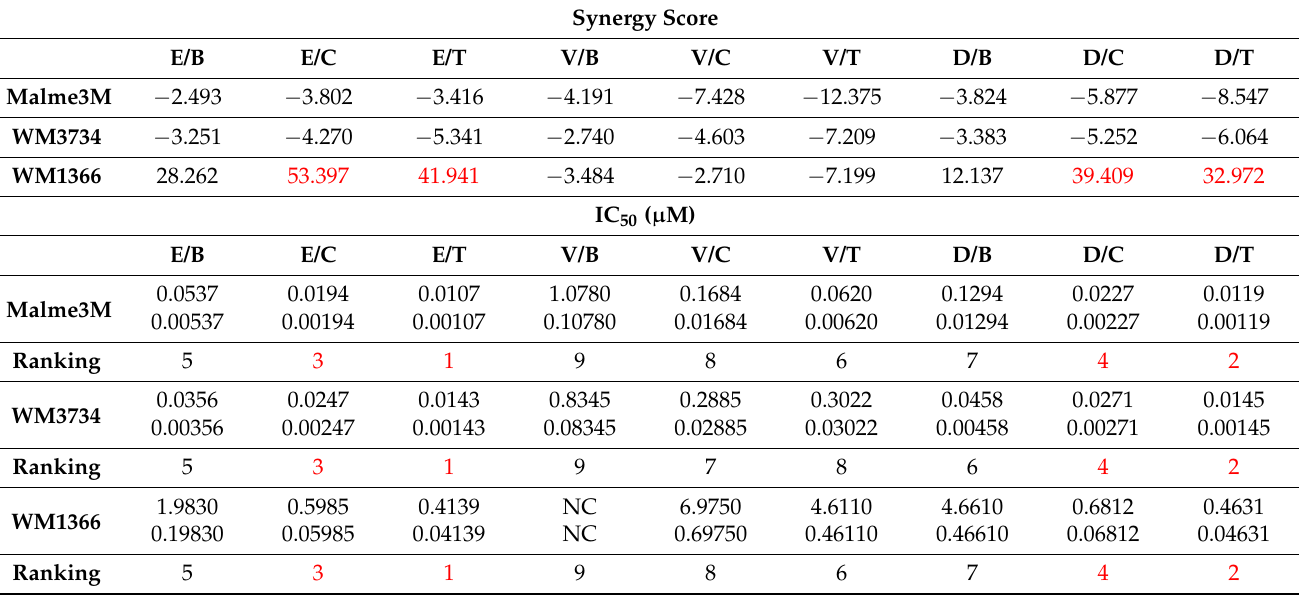
Table 2. Comparison of synergy score and IC 50 data of the different BRAFi and MEKi combinations. Synergy